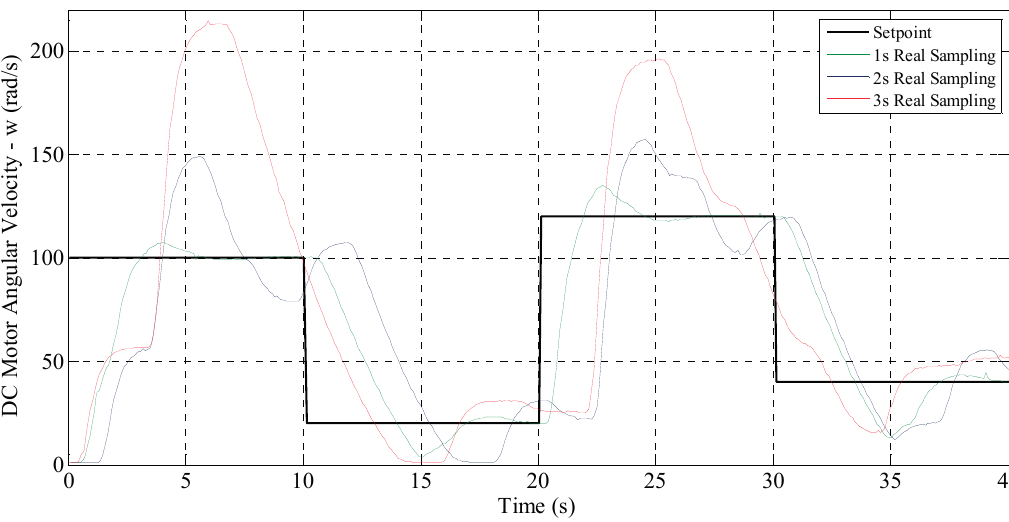
Figure 4. Feasibility of using wireless sensor in closed-loop control